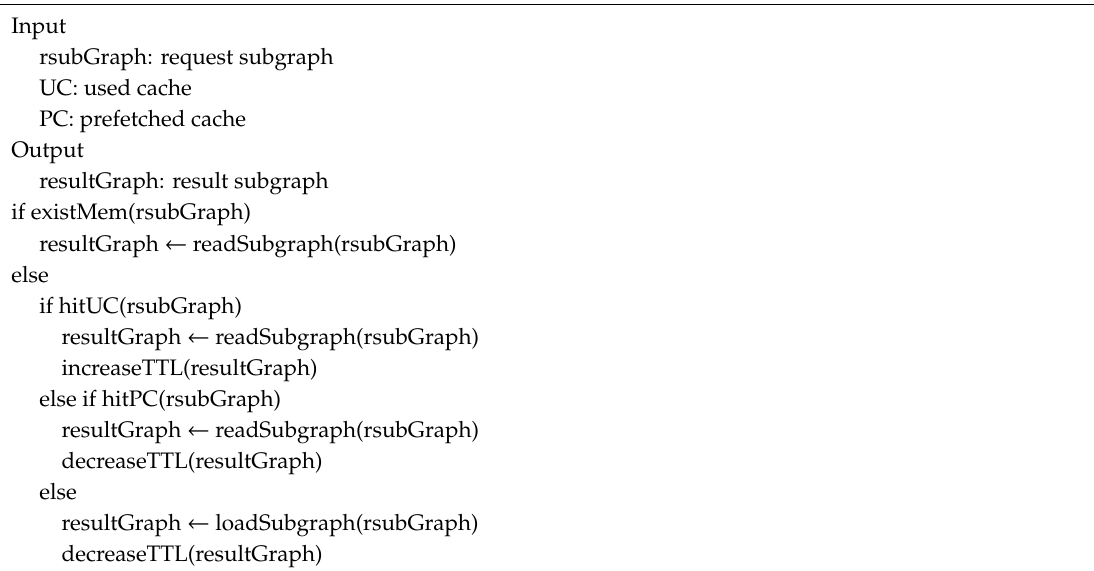
Algorithm 1 subgraphAccess(rsubGraph, UC,